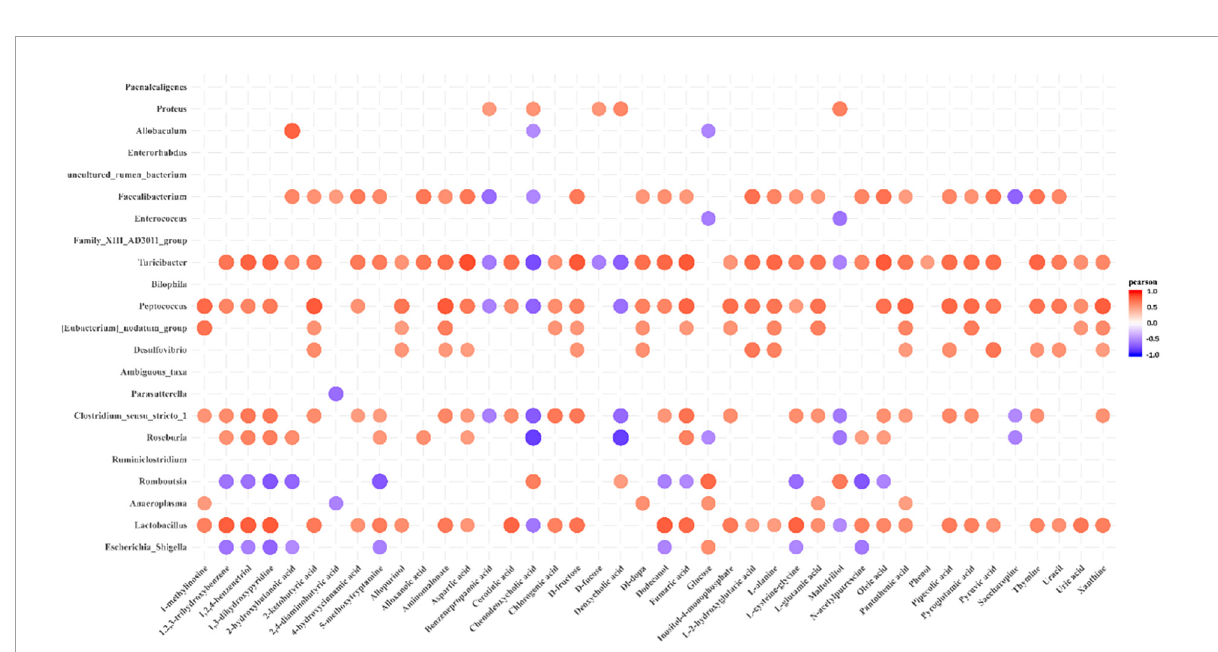
FIGURE6 Pearson’s correlation analysis of faecal microbiota and metabolites. p -values are plotted from blue to red, where blue represents positive correlation and red represents negative